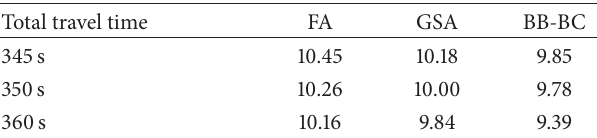
Table 4: Energy consumption (kwh) for different time limits (no passenger).